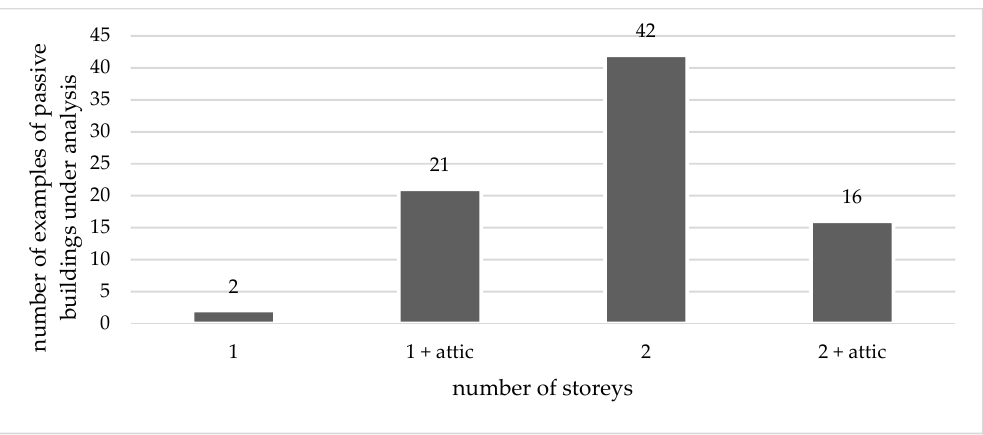
Figure 3. Analysis of passive buildings in terms of number of buildings stories.